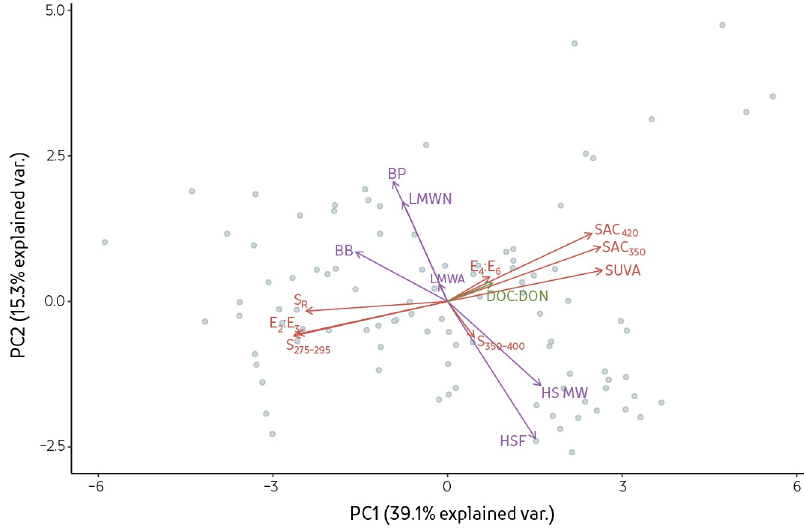
Fig 3. Principal component analyses for samples from different ecozones. Grey dots represent individual samples, while vectors represent absorbance (red), elemental (green), and LC-OCD (purple) compositional measures.